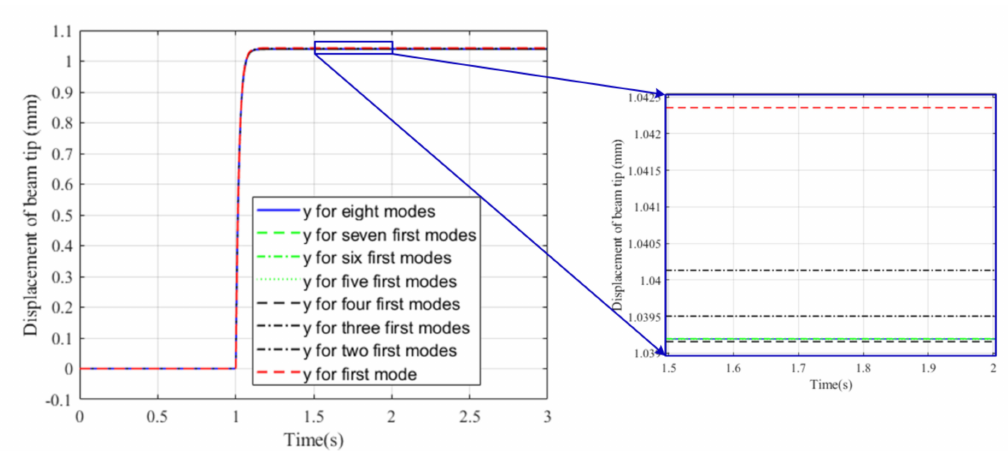
Figure 5. Comparison of output values for eight models differing in the number of